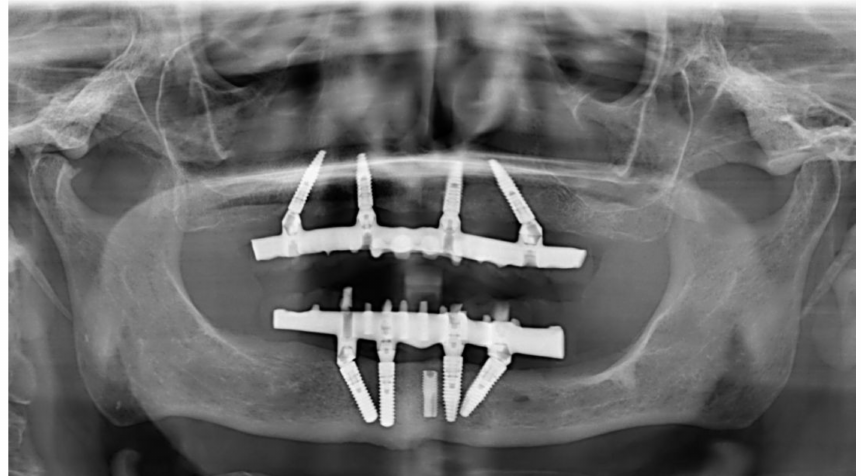
Figure 8. Panoramic radiograph after 7 years of use in maxillary-implant-supported rehabilitation. In the mandible, the same treatment was performed with standard-diameter implants. One previously placed implant had fractured and was left in the subgingival region. It was not included in the rehabilitation